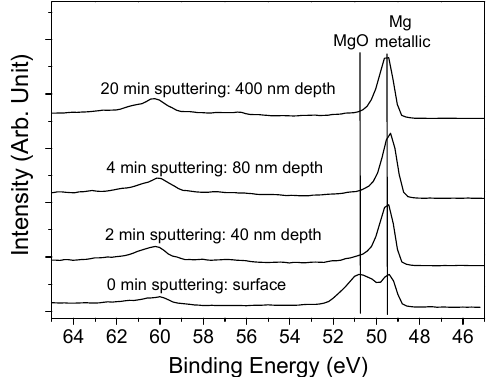
Figure 3. Evolution of the Mg2p line during the depth profiling of the Mg films prepared for α = 0° and P Tot = 0.26 Pa.